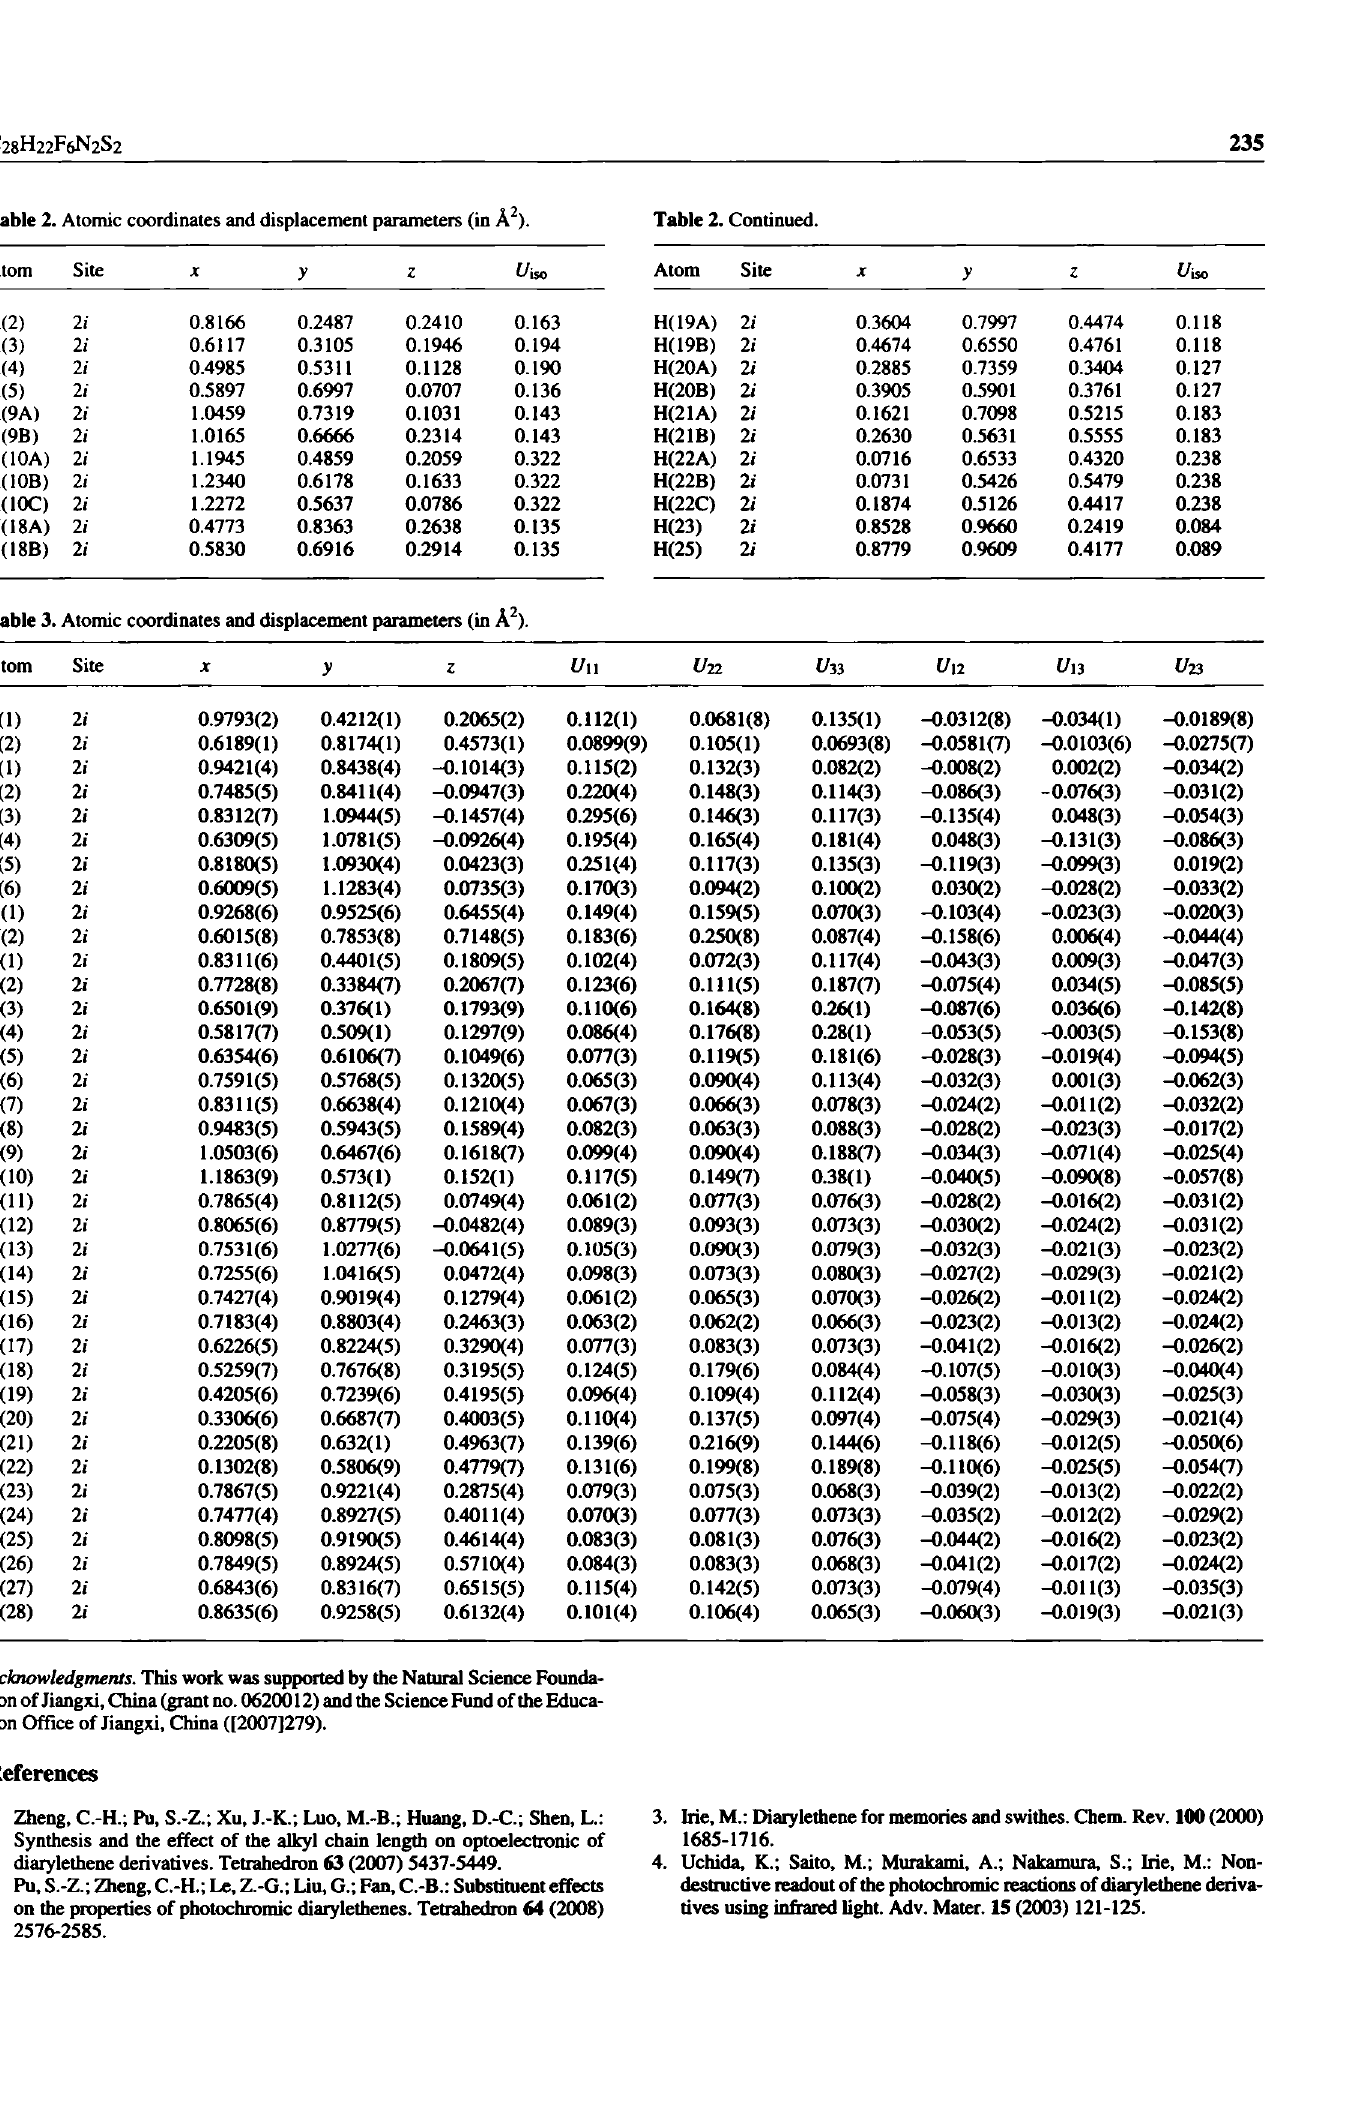
Table 3. Atomic coordinates and displacement parameters (in Â 2